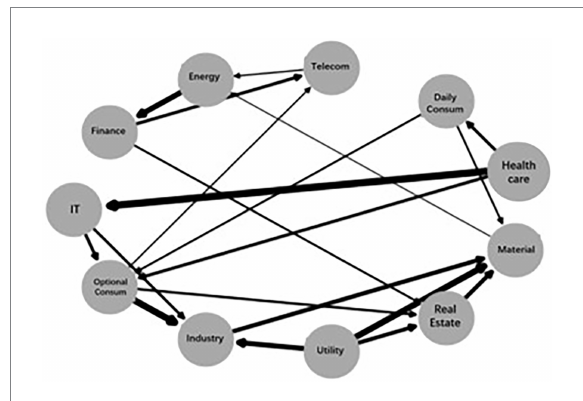
FIGURE 5 Directed acyclic graph for total systemic risk